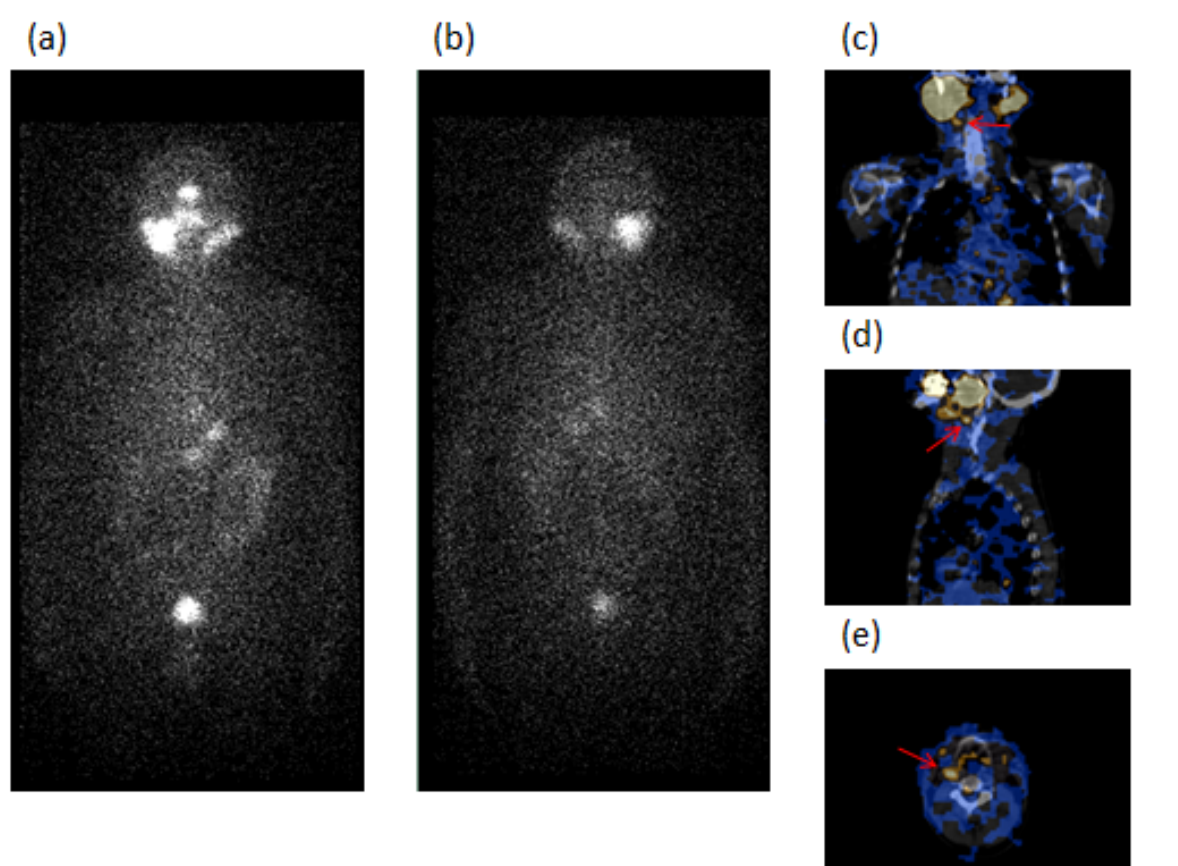
Figure 2. A 64-year-old male patient (Case 9, Table 2) submitted to total thyroidectomy and radioiodine ablation for papillary carcinoma (PC) classic variant, tumor diameter of 11 mm with associated Graves’ disease (GD). The figure refers to an image acquired after 22 months of follow-up. 131 I-WBS, after a diagnostic dose of 185 MBq, in both anterior ( a ) and posterior ( b ) views excluded the presence of pathologic radioiodine-avid foci. SPECT/CT in coronal ( c ), sagittal ( d ), and transaxial ( e ) slides showed one radioiodine-avid focus in the posterior region to the submandibular right gland (red arrow). The focus was classified as metastatic lymph node and treated with radioiodine ablation. Thyroglobulin: undetectable. AbTg: 143 IU/mL.